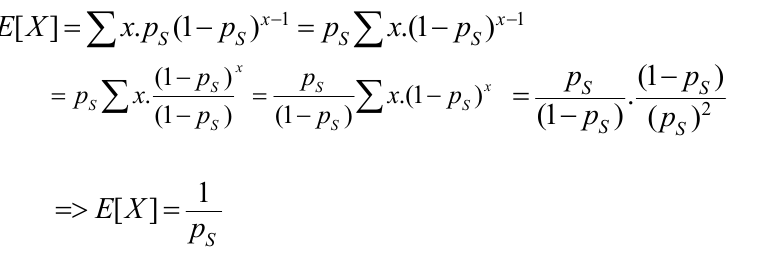
Figure 7. Probability of signature-code collision with respect to φ , m and n with Ө = 2.